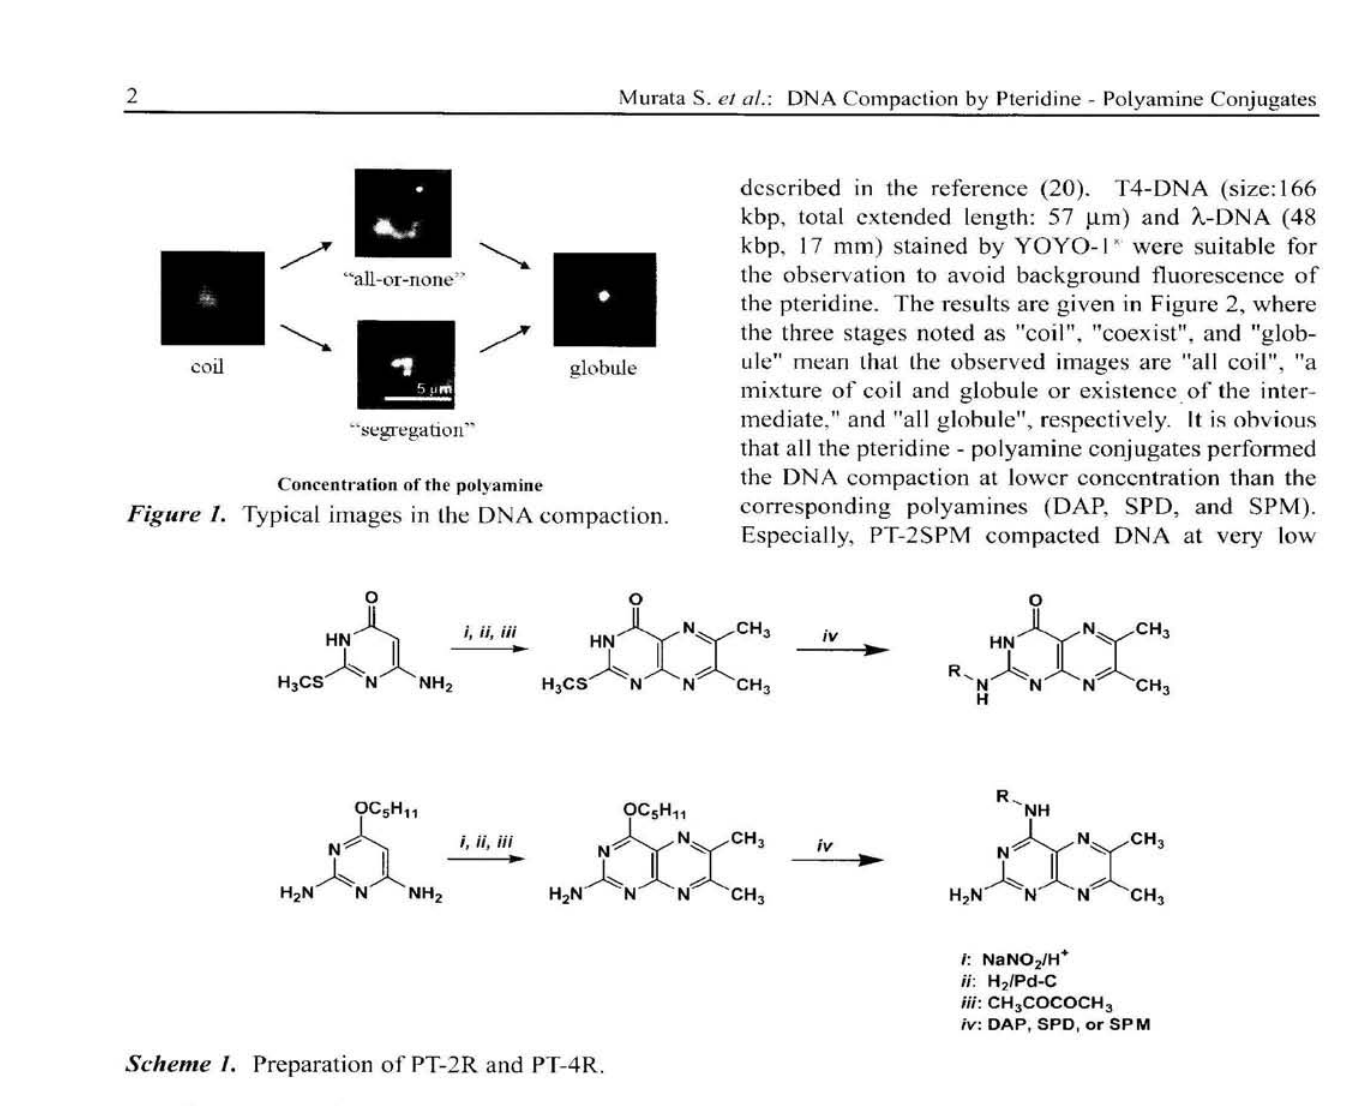
Figure 1. Typical irnages in the DNA compaction.